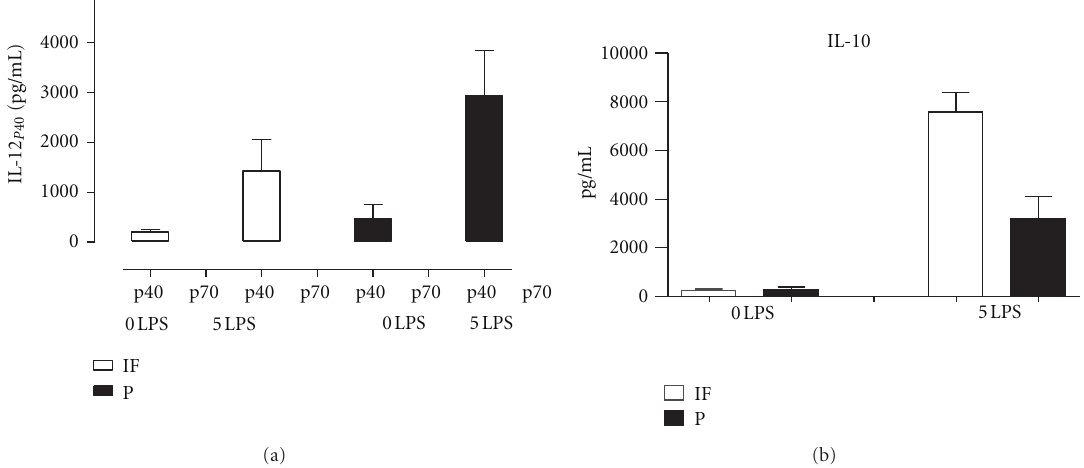
Figure 3: (a) Patients and methods as in Figure 1. Ex vivo IL-12 p40 release is stimulated by LPS. Di ff erence between pM φ from an infection- free period ( n = 8) and an episode of peritonitis ( n = 8), was statistically not significant. Using an ELISA specific to the bioactive, hetero- dimeric IL-12 p70 , no active IL-12 was detectable in supernatants from uninfected patients ( n = 5) nor in those with peritonitis ( n = 5), whether or not the cells were stimulated with LPS. Consistent with this finding, virtually no IL-12 p35 mRNA was expressed (data not shown). All peritonitis episodes were caused by gram positive bacteria. (b) ex vivo IL-10 release from pM φ from infected patients ( n = 8) is decreased as compared with pM φ from an infection free environment ( n = 8), ( P < 0 . 01). IL-10 levels in peritoneal e ffl uents from peritonitis were higher compared with infection-free e ffl uents, 235 pg/mL and 25 pg/mL, respectively (data not shown in figure) .